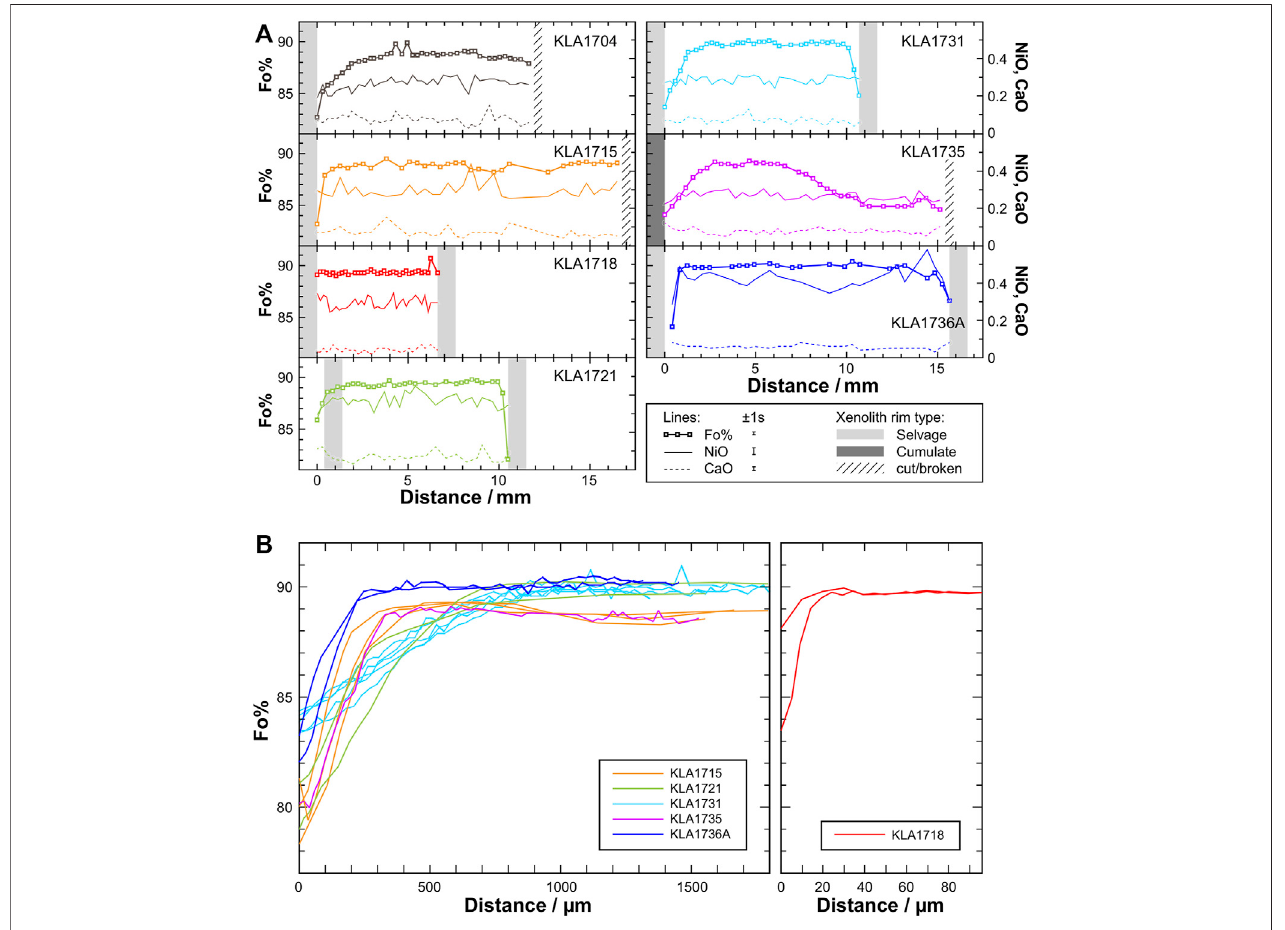
FIGURE6|(A) Zonationsinforsteritecontent(Fo%;lineswithsymbols),NiO(withoutsymbols)andCaO(dashedlines)ofolivinesacrosstheinvestigatedperidotite xenoliths.ScaleonleftsideofeachplotisforFo%,rightsideforNiOandCaOinwt%.Errorbarsinlegendindicateanalyticaluncertainty(±1standarddeviation).Notethat most xenoliths show a plateau of broadly constant composition in their central part. (B) Zonations in Fo% at the rims of the peridotite xenoliths. The gradual decrease in Fo% extends over 0.3 – 1.6 mm length, except for sample KLA1718 where gradients are only 0.03 – 0.04 mm wide.